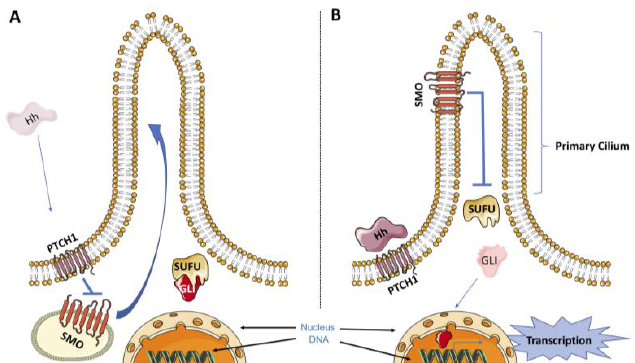
Figure 1. A simplified model for canonical HhP. ( A ) The Hedgehog receptor PTCH1 inhibits SMO signaling in the absence of the Hedgehog ligand, which turns off the Hedgehog signaling pathway.